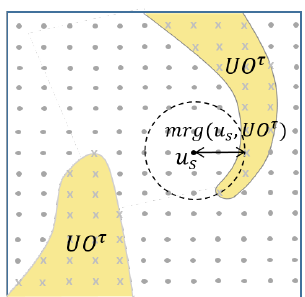
Figure 4. A sampling-based estimate of u s margin , mrg ( u s , UO τ ) is the weighted Euclidean